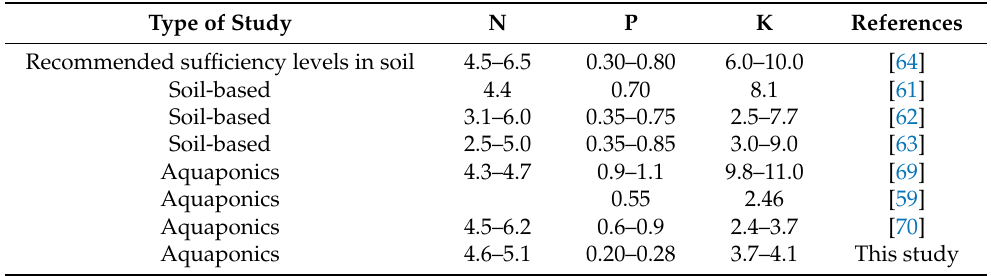
Table 6. Nitrogen, phosphorus, and potassium concentrations (%) in lettuce leaves in this study compared to other studies.